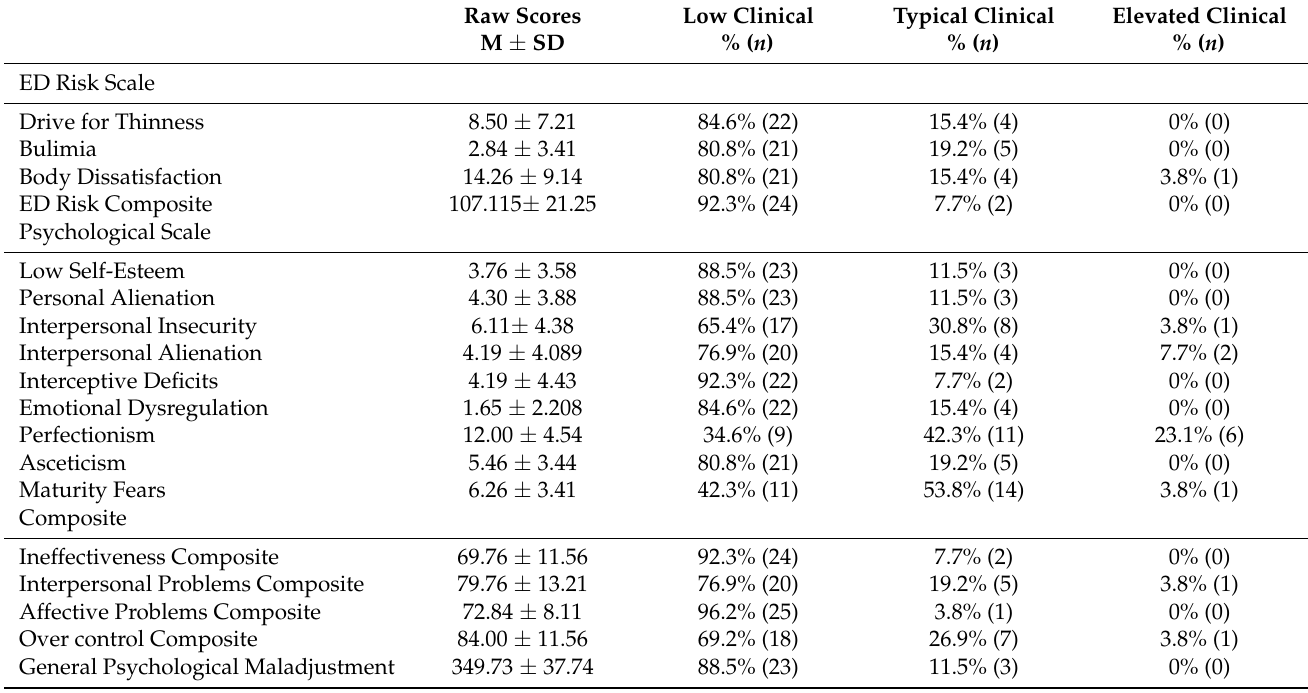
Table 3. Eating disorder scores (from EDI-3) among dancers ( n =